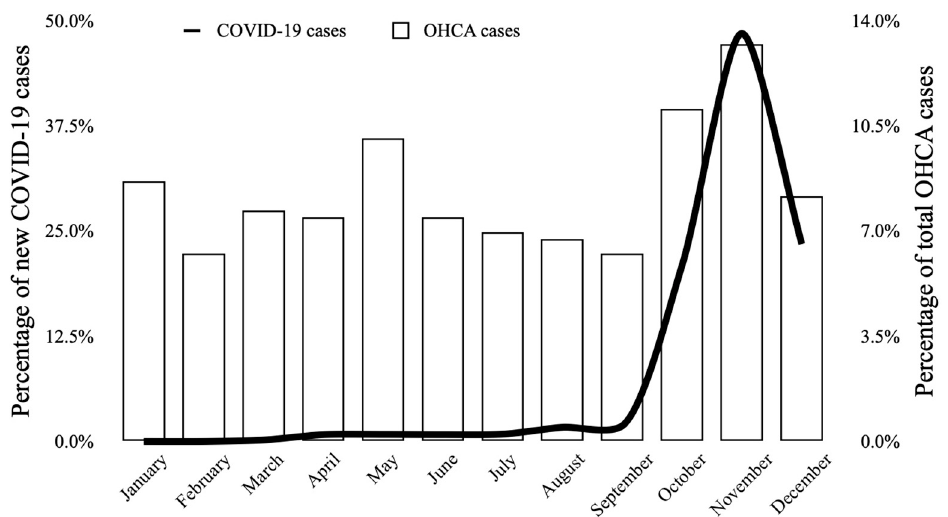
Figure 6. Monthly distribution of out-of-hospital cardiac arrest (OHCA) occurrence and new COVID-19 cases diagnosed in Poland in year 2020. Black line represents the percentage of new COVID-19 cases diagnosed in a particular month (data based on the daily reports of The Ministry of Health of Poland).